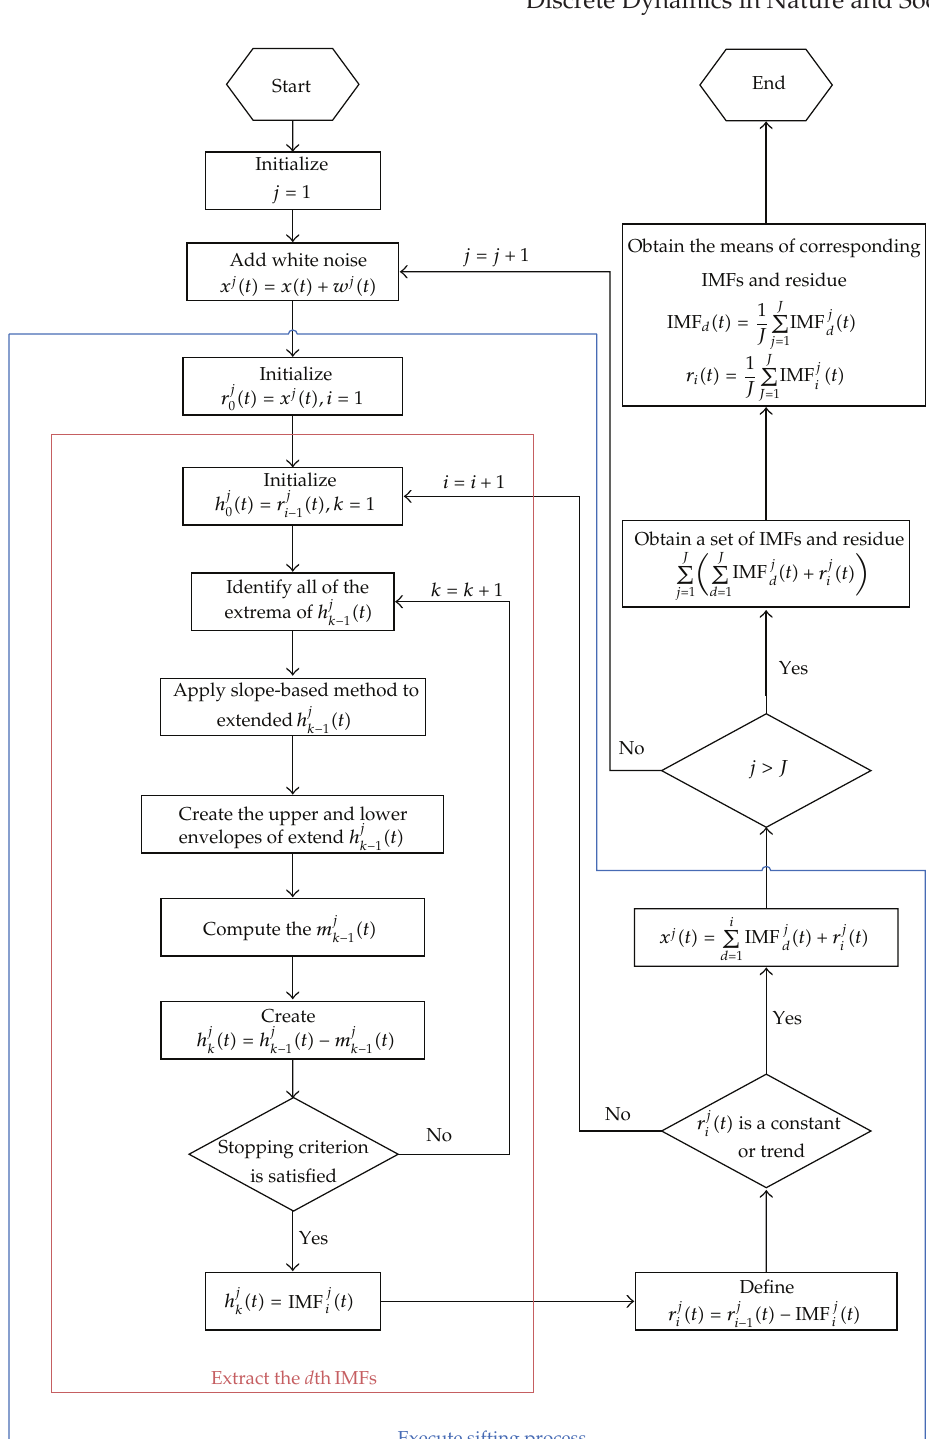
Figure 1: The EEMD with slope-based